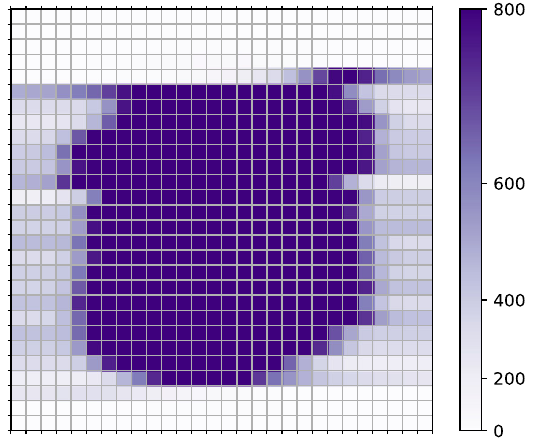
FIG. 4. Bond dimensions of the MPS trained with j T j ¼ 1000 800 . Final average NLL MNIST samples, constrained to D max ¼ reaches 16.8. Each pixel in this figure corresponds to the bond dimension of the right leg of the tensor associated to the identical coordinate in the original image.